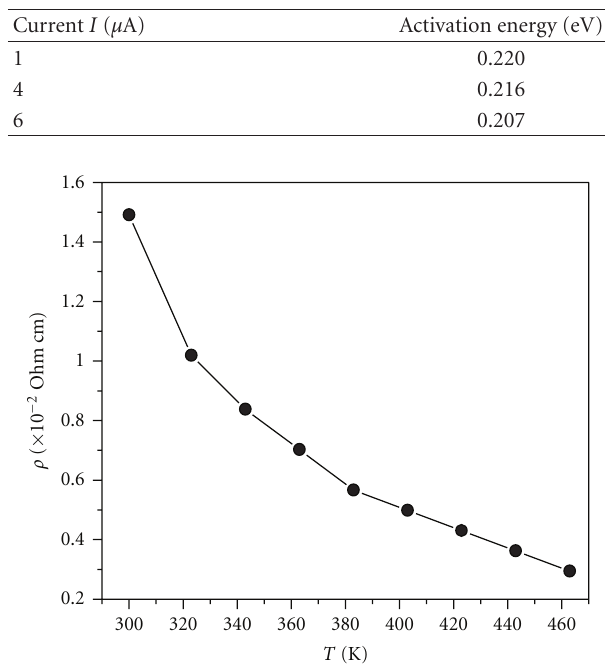
Table 1: Variation of activation energy with current.